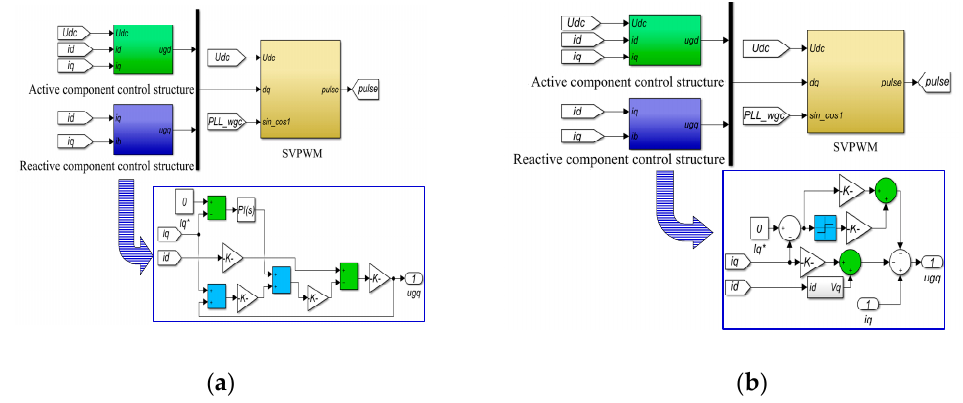
Figure 9. Simulation model of reactive component control structure: ( a ) controlled by backstepping control method; ( b ) controlled by SMVS.